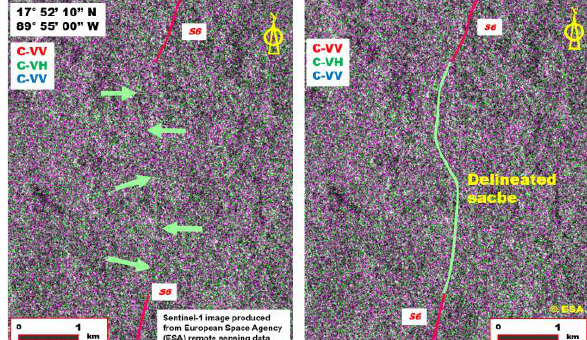
Figure 9. Connection between the two Sacbe #6 (S6) segments of Folan et al. (1995) located inside a forested area, as displayed on a false-colour composite made with the Sentinel-1A radar image (C-VH band in the red and blue, C-VV band in the green) acquired in May 2016. The location of the sacbe is indicated on the left panel by green arrows.